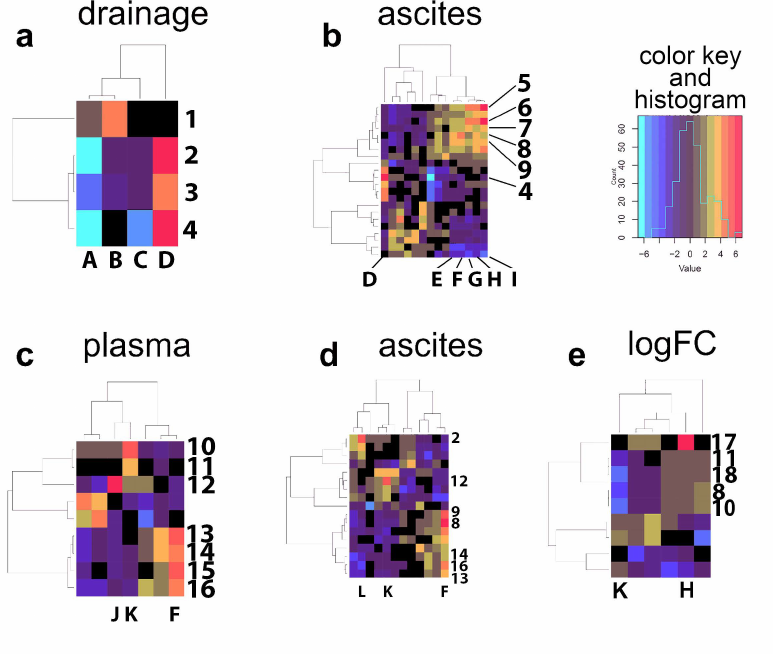
Figure 4. Cluster maps showing bidirectional clustering of clinical covariates from Experiment 1; ( a ), metabolites in drainage fluid for postoperative surgical patients (n = 33); ( b ), metabolites in cirrhotic ascites fluid (n = 33); from Experiment 2: ( c ), metabolites in paired plasma (n = 17); ( d ), metabolites in paired cirrhotic ascites fluid (n = 17); ( e ), metabolites as log fold concentration (logFC) difference between cirrhotic ascites fluid and paired plasma (n = 17) in Experiment 2.